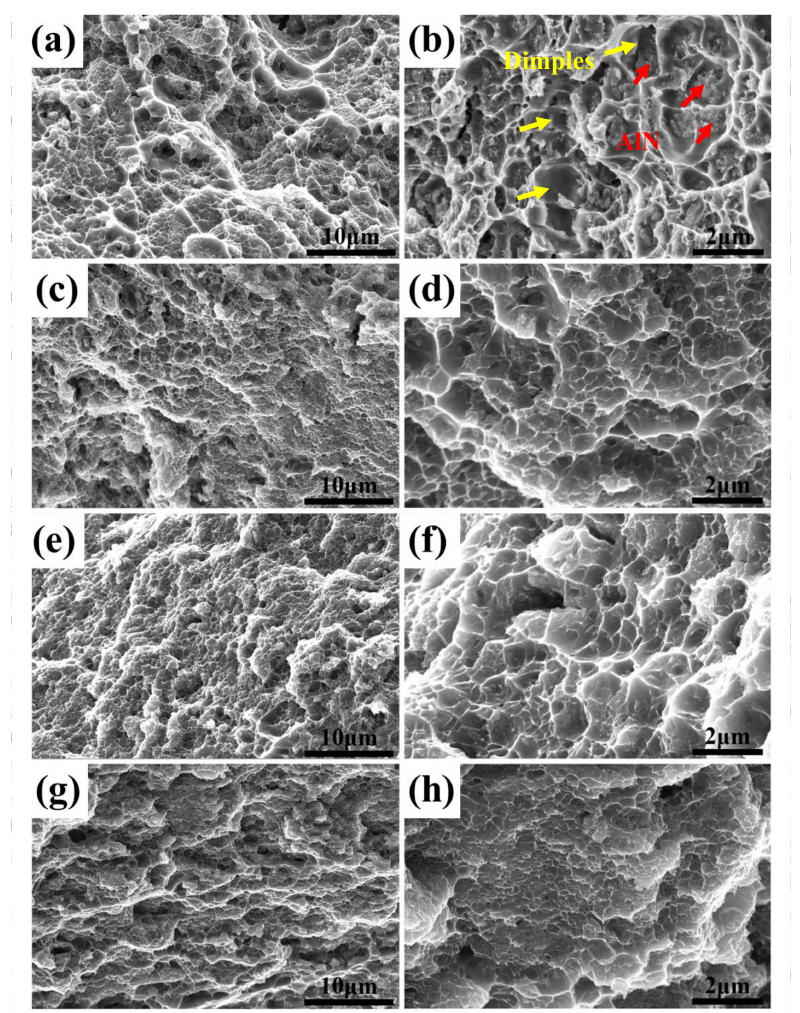
Figure 7. The fracture surfaces of AlN / Al composites after di ff erent rolling thickness reductions at 300 ◦ C: ( a , b ) 0%; ( c , d ) 16%; ( e , f ) 40%; ( g , h )